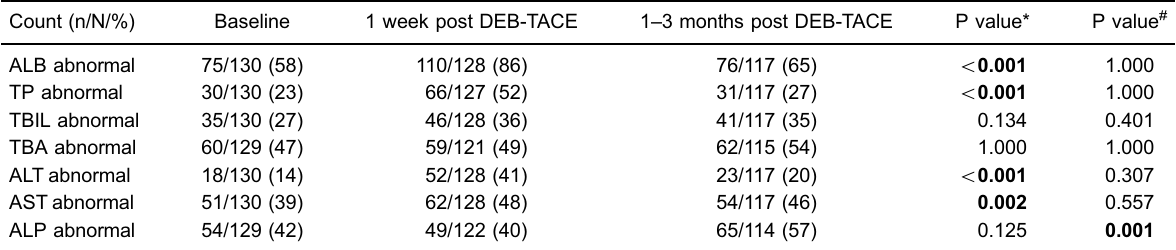
Table 2. Liver function before and after drug-eluting bead transarterial chemoembolization (DEB-TACE) treatment in hepatocellular carcinoma patients (131 records). Count (n/N/%)